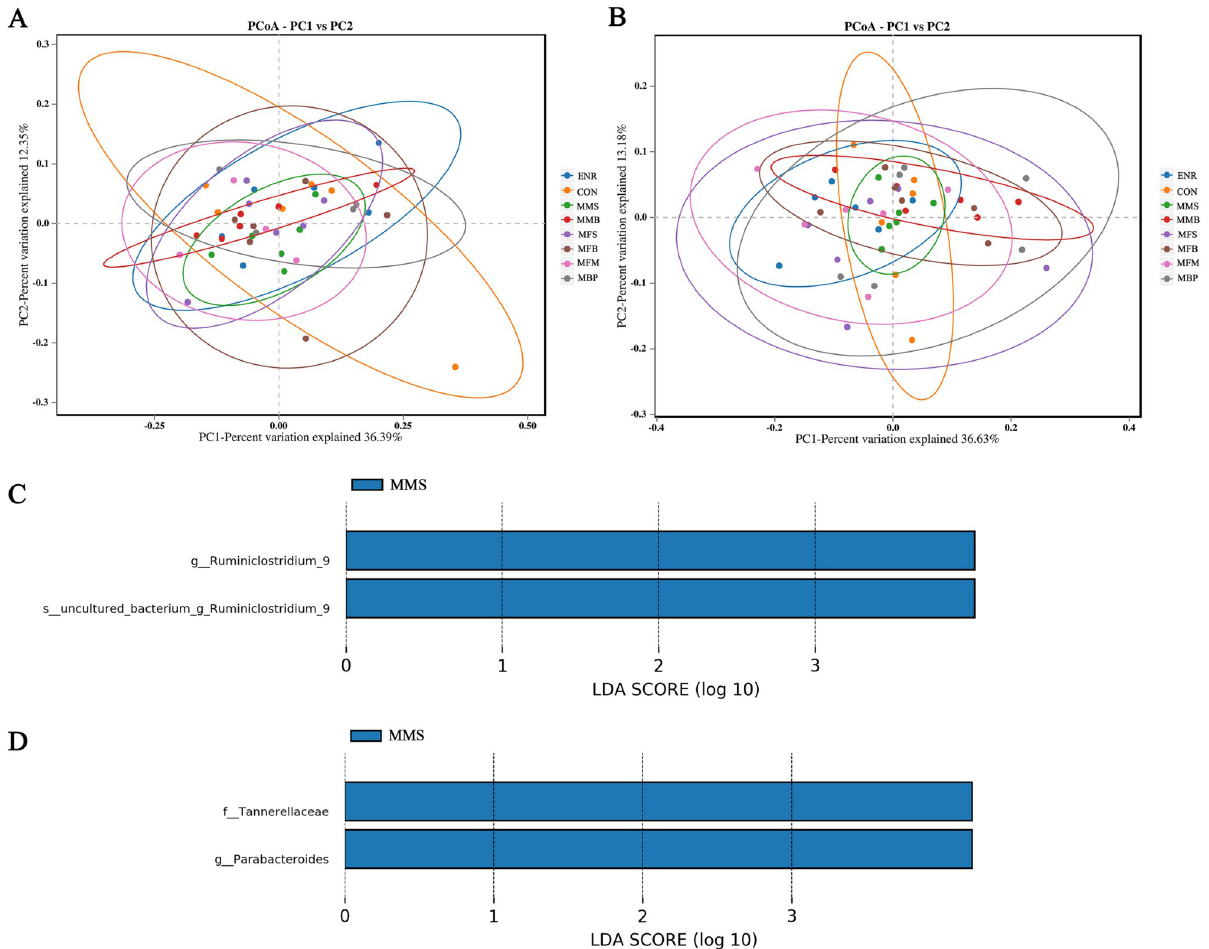
Fig 7. Beta diversity and Linear discriminant analysis effect size analysis of the microbiome residing in the cecal chyme of broilers at 21 and 42 days old. (A) PCoA plot at 21d. (B) PCoA plot at 42d. (C) LDA distribution histogram at 21d (LDA scores > 4). (C) LDA distribution histogram at 42d (LDA scores > 4). CON, control diet; ENR; CON + 100 mg/kg ENR, MMS; CON + 2000 mg/kg MOS + 300 mg/kg MAN + 1500 mg/kg SB, MMB; CON + 2000 mg/kg MOS + 300 mg/kg MAN + 500 mg/kg BS, MFS; CON + 2000 mg/kg MOS + 9000 mg/kg FOS + 1500 mg/kg SB, MFB; CON + 2000 mg/kg MOS + 9000 mg/kg FOS + 500 mg/kg BS, MFM; CON + 2000 mg/kg MOS + 9000 mg/kg FOS + 300 mg/kg MAN, MBP; CON + 2000 mg/kg MOS + 500 mg/kg BS + 37 mg/kg PT. SB; Sodium butyrate, FOS; Fructose oligosaccharide, PT; Phytase, BS; Bacillus subtilis, MOS; Mannose oligosaccharide, MAN;